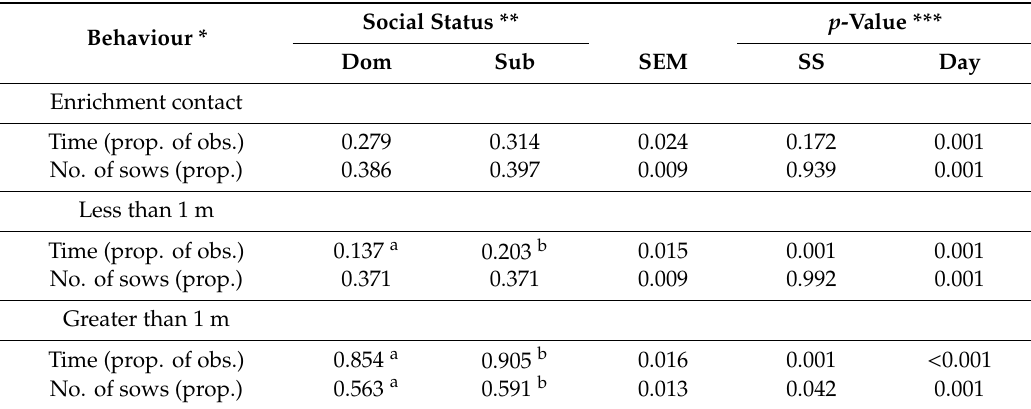
Table 4. E ff ects of social status and day of observation on time spent (proportion of observations) and number of sows (proportion of sows) in contact with enrichment, less than 1 m or greater than 1 m from enrichment.